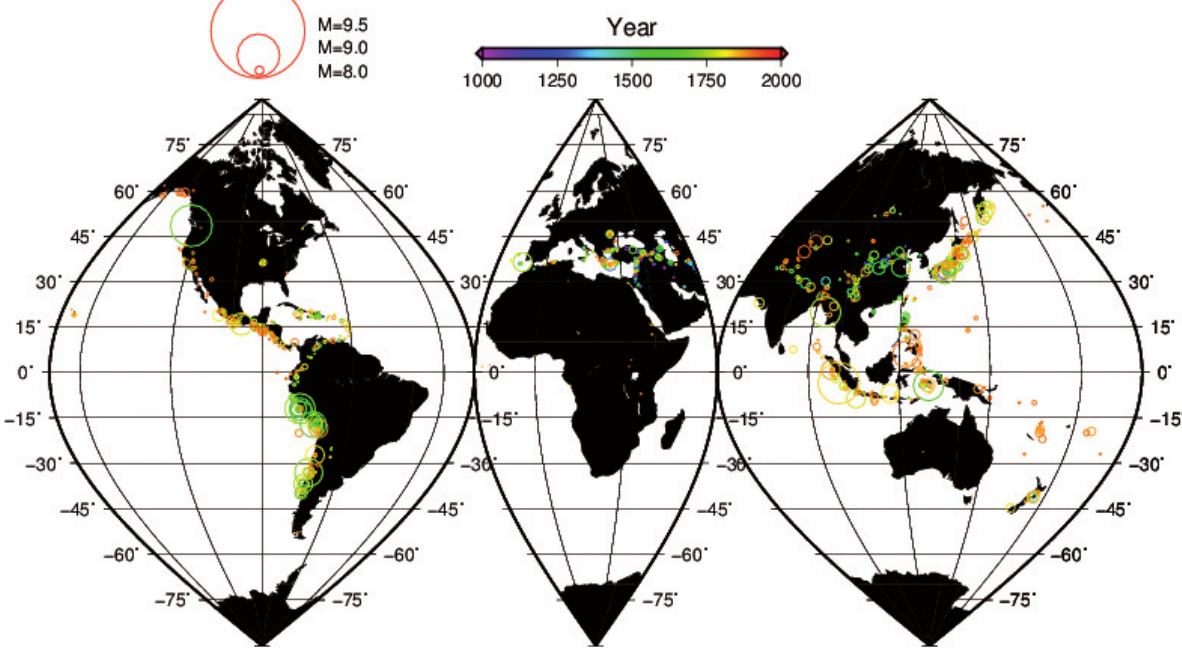
Figure 2. Geographic distribution of the epicenters included in the GEH catalogue [Albini et al. 2014a]. The color indicates the year of oc-